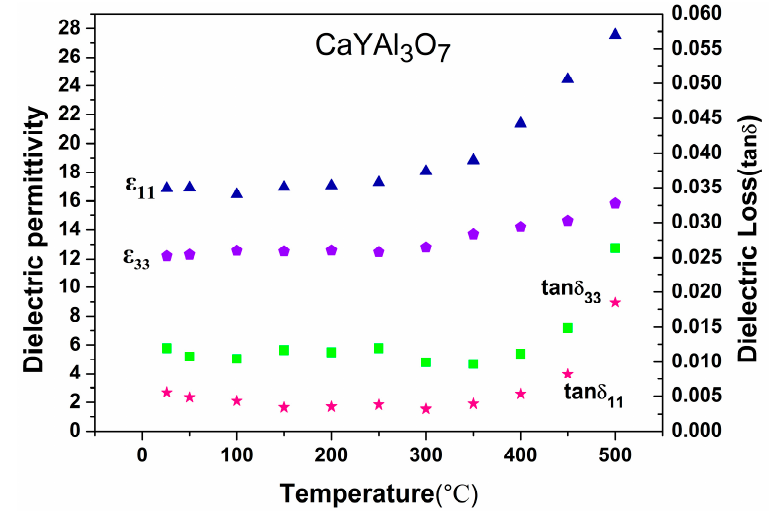
Figure 5. Dielectric permittivity and dielectric loss (tan δ ) of CYAM crystal as a function of temperature.